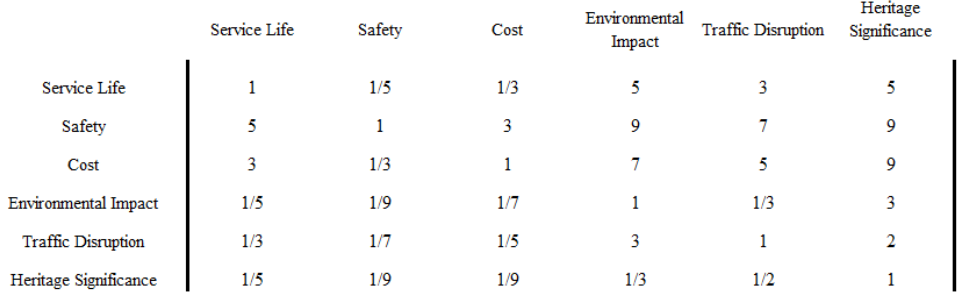
Figure 7. AHP Matrix for Criteria Weighting.